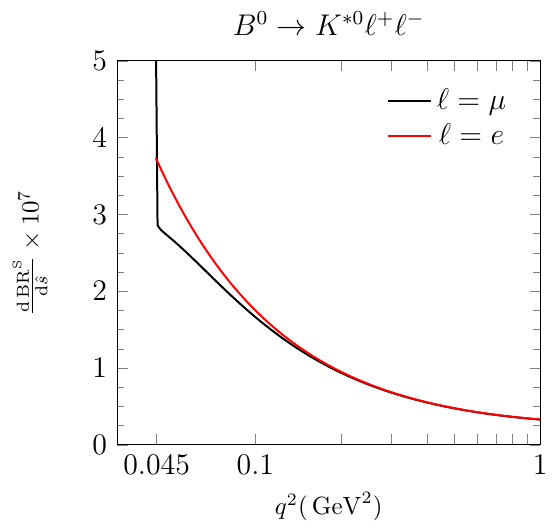
Figure 4 . Di(cid:11)erential distributions of the branching ratio for the pure Sommerfeld correction, as a function of q 2 for the B ! K (cid:3) ‘ + ‘ (cid:0)